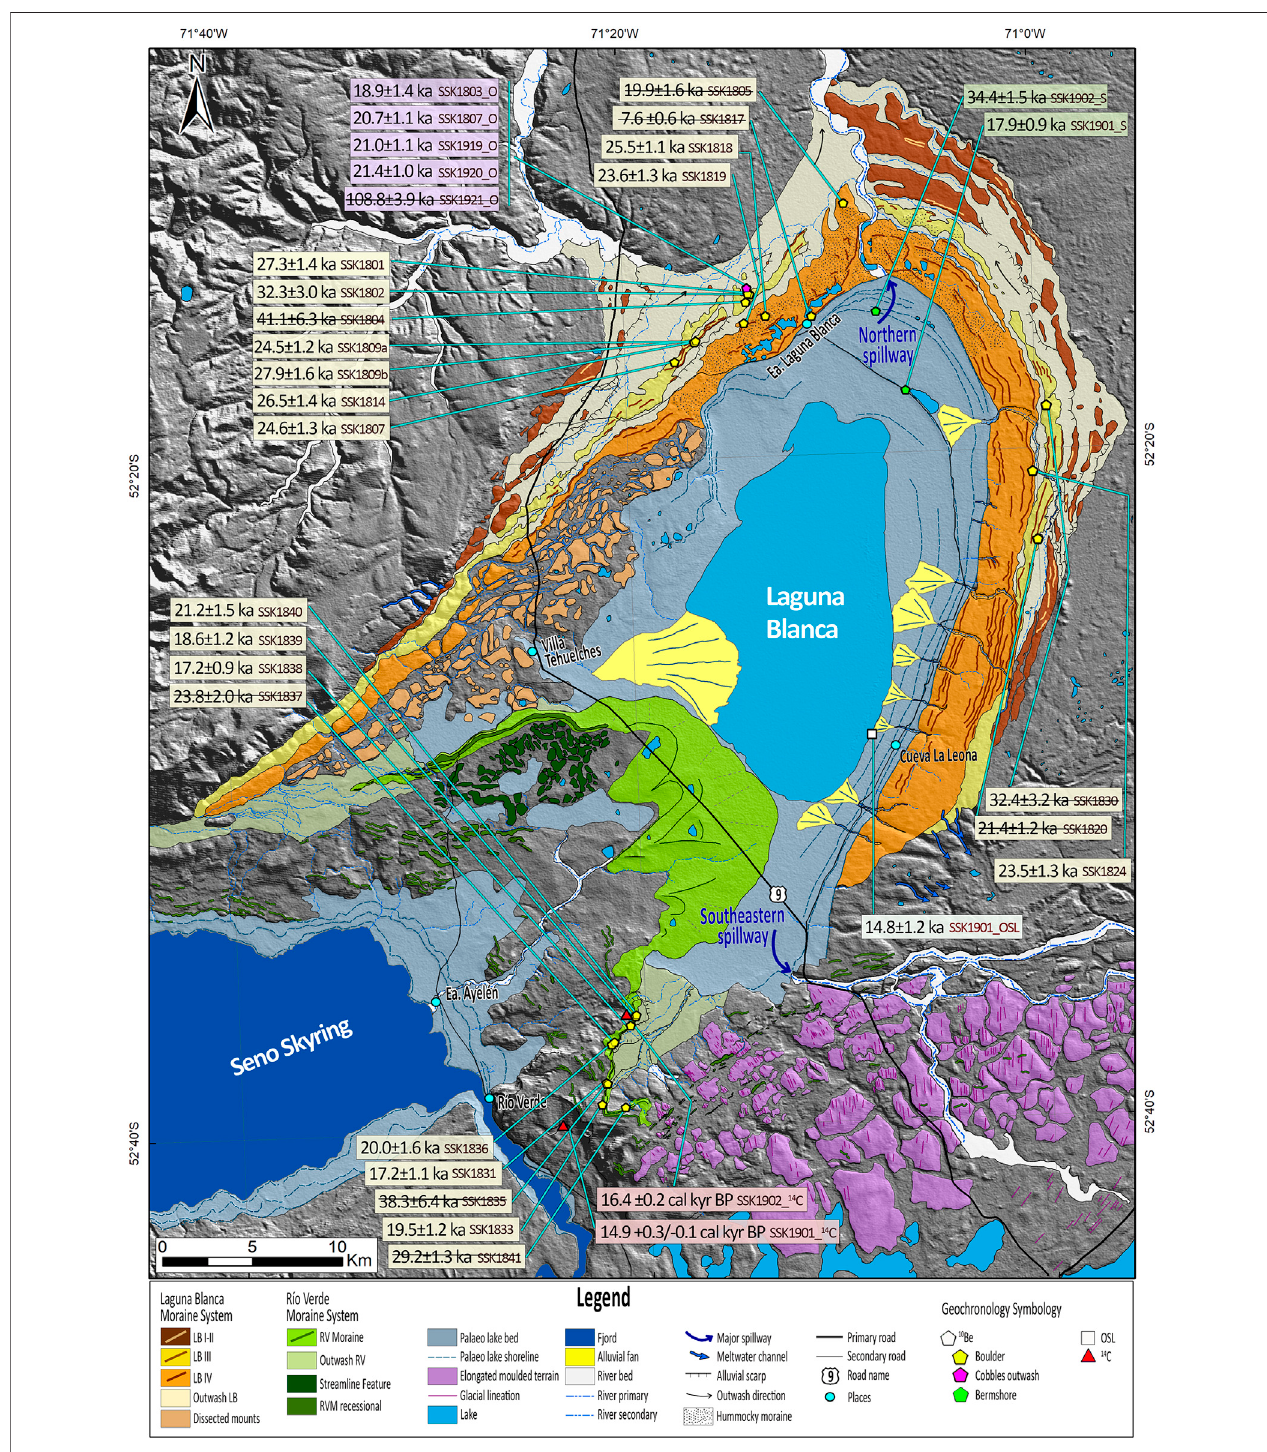
FIGURE 3 | Geomorphological map of Skyring ice lobe area. Sample locations of the cosmogenic, OSL, and radiocarbon dates are indicated. Background is a hillshade from SRTM showing the topography. Dates treated as outliers are shown crossed-out, see text for discussion.